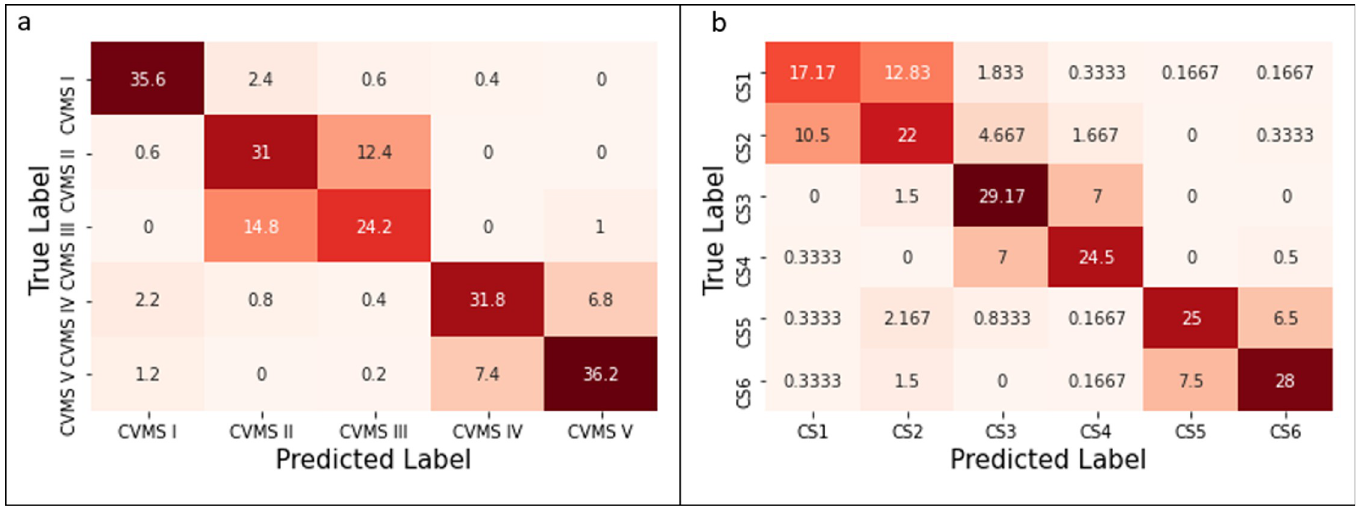
Fig 7. Average confusion matrices after fivefold testing for (a) 5-stage classification and (b) 6-stage classification are shown.